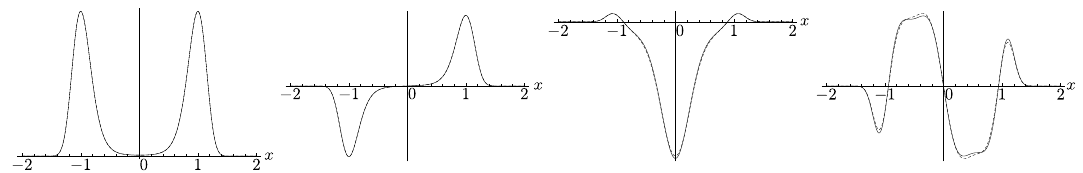
Figure 3 . The eigenfunctions h x j k i of the transfer matrix ^ T ( k = 0 ; 1 ; 2 ; 3 from left to right) for the Langevin algorithm (real lines) and the Metropolis algorithm (dotted lines). We see that they agree with great